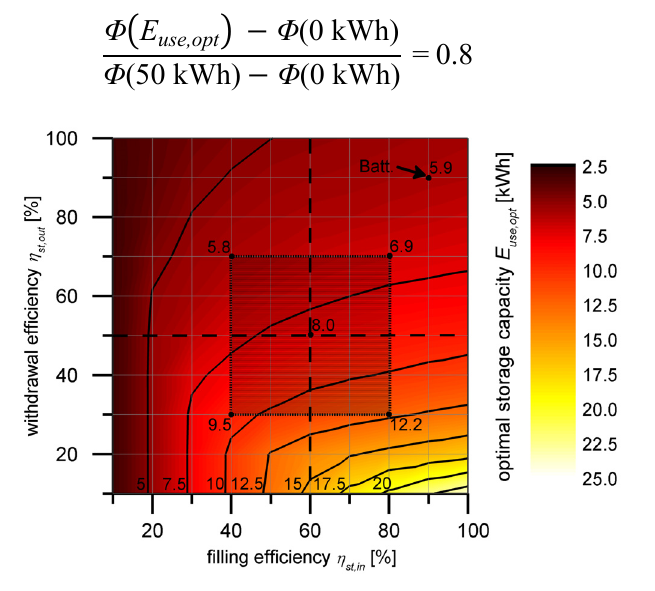
Figure 10. Optimal storage capacity dependent on storage